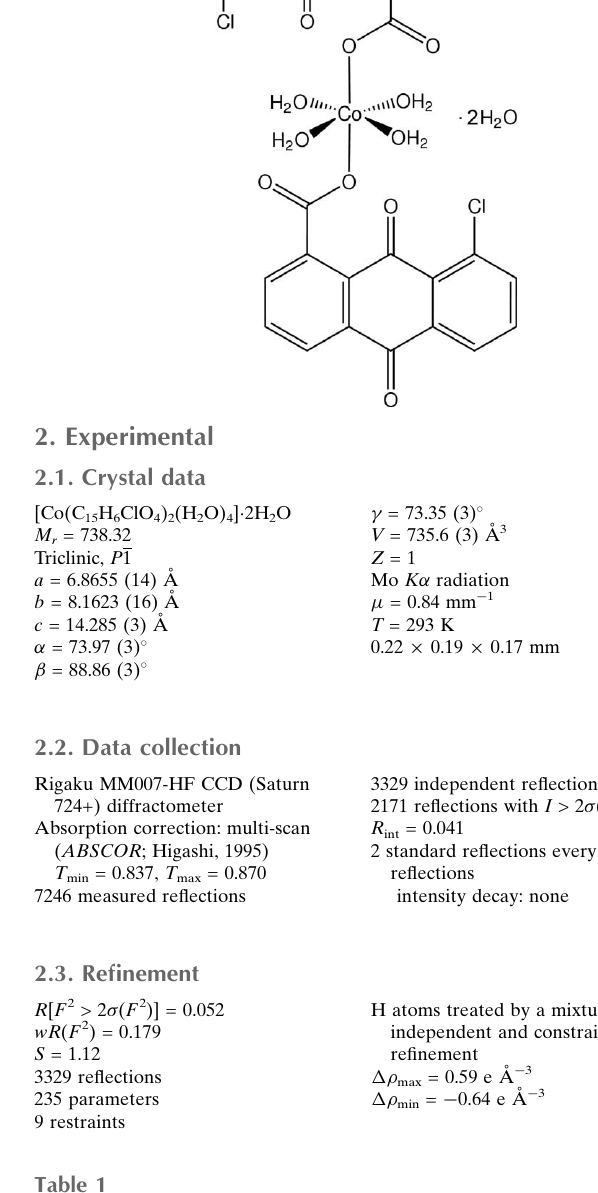
Hydrogen-bond geometry (A˚ , (cid:3)